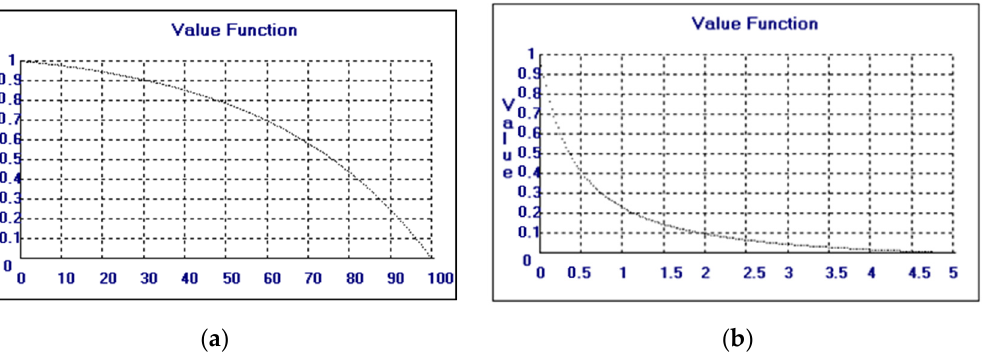
Figure 2. Examples of marginal value functions: ( a ) downward concave value function for min value functions for min preference attributes; ( b ) upward concave value function for min value functions for min preference